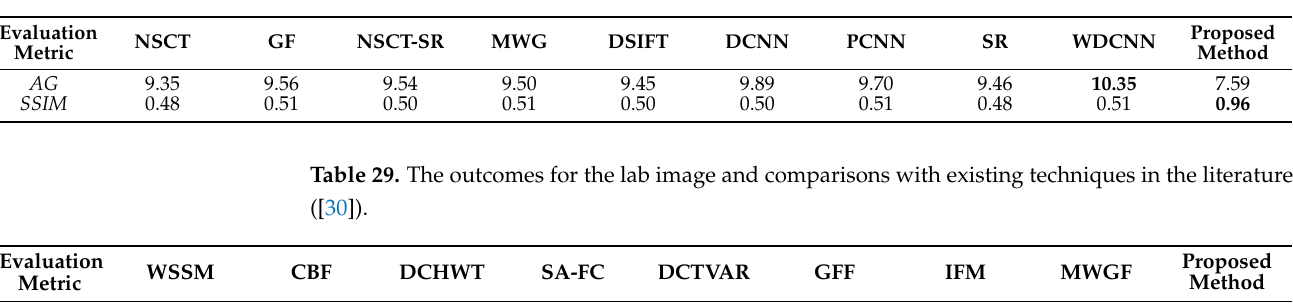
Table 28. The outcomes for the lab image and comparisons with existing techniques in the literature ([28]).